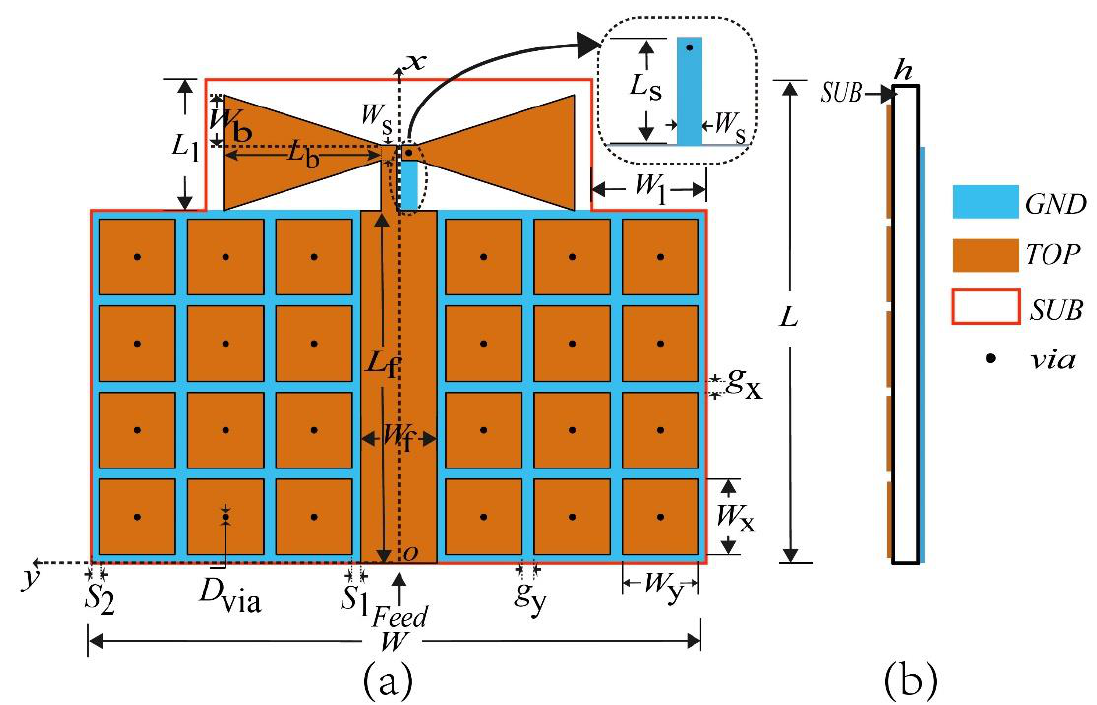
Figure 1. Geometry of the proposed metamaterial-based low-profile wideband antenna and the coordinate system. ( a ) Top view, ( b ) Side view.